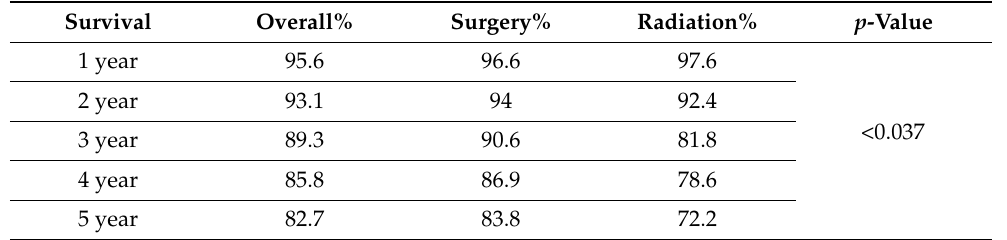
Table 7. Survival data of 609 patients with parathyroid cancer from the Surveillance, Epidemiology, and End Results (SEER) database, 1975–2016.